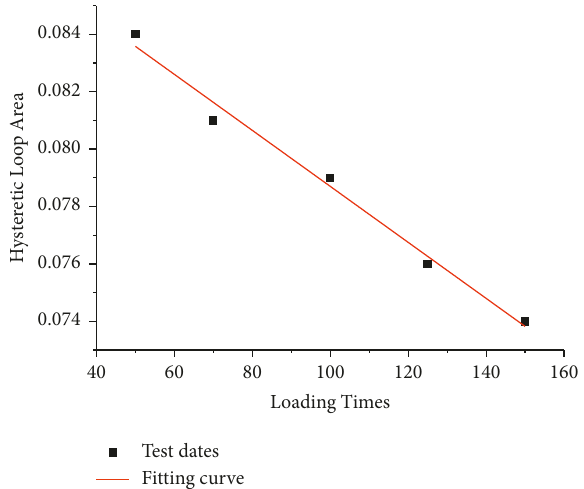
Figure 8: The hysteretic curves while σ loop curves. (c) The 140 th –154 th hysteretic loop curves.